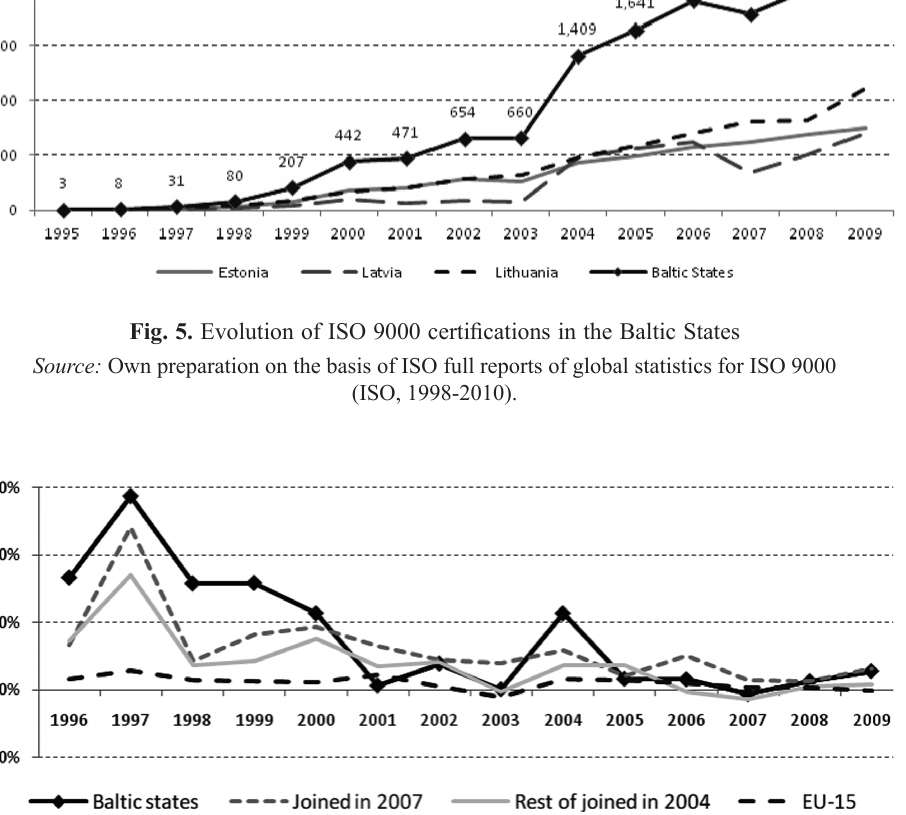
Fig. 6. Comparative evolution of percentual growth of ISO 9000 certifications. (Baltic States, Rest of joined in 2004, joined in 2007 and EU-15) Source: Own preparation on the basis of ISO full reports of global statistics for ISO 9000 (ISO,